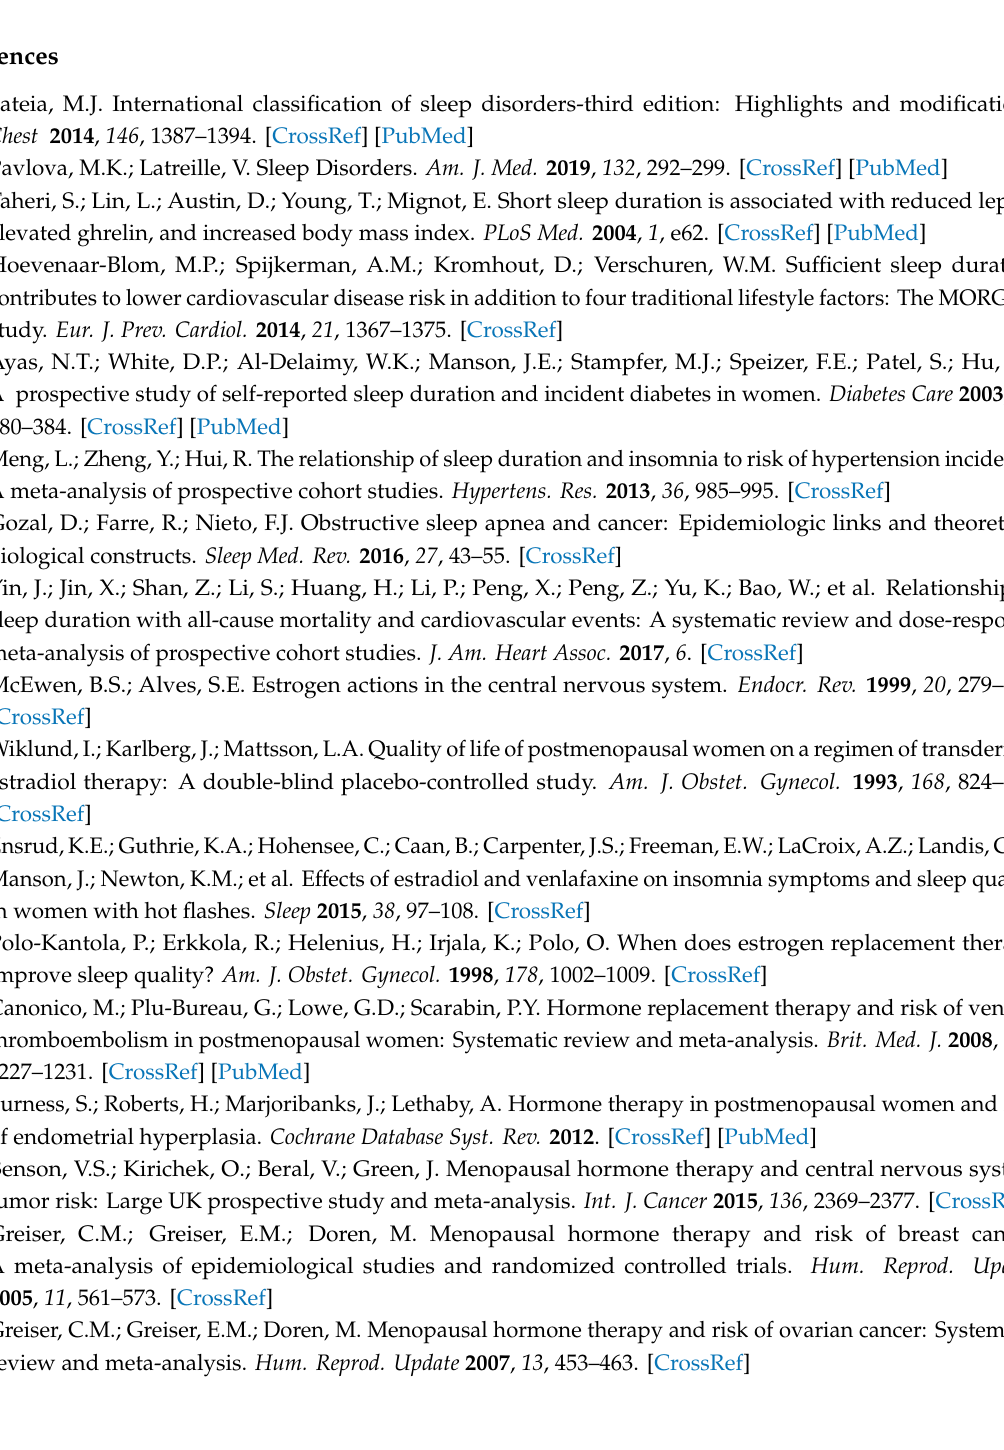
Table S1. The classifications of the